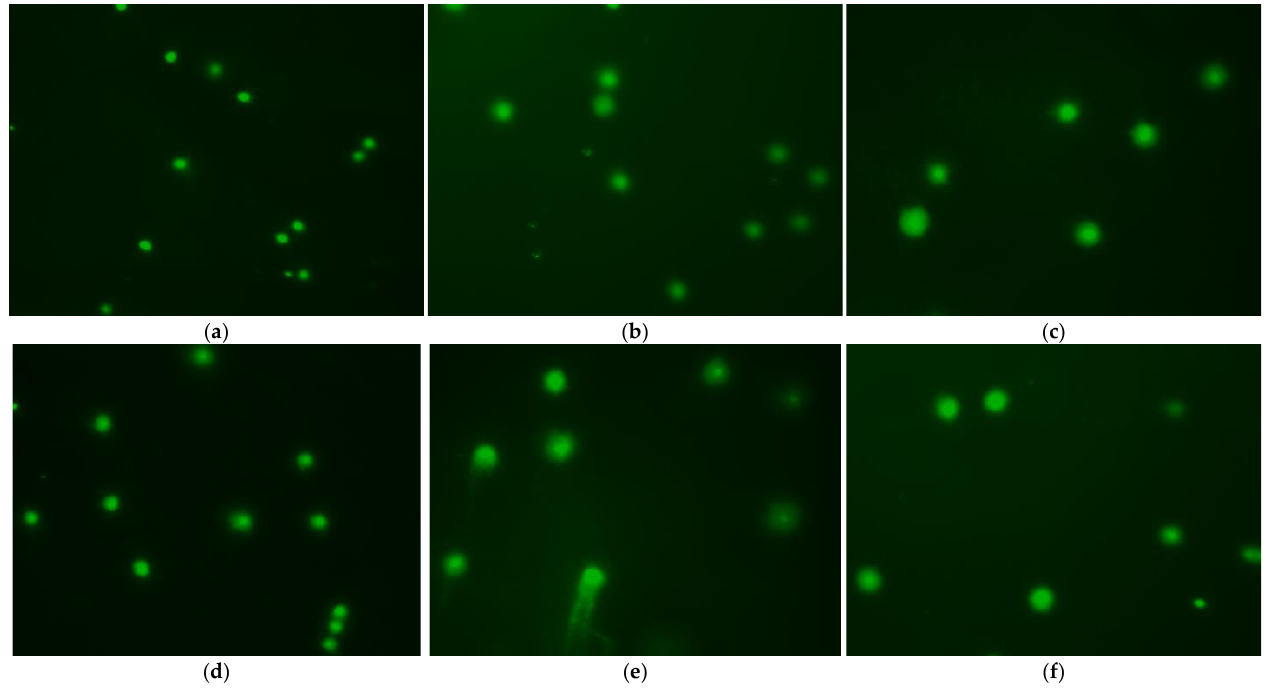
Figure 7. Fluorescent images of frozen and fresh sperm from roughscale sole, Clidoderma asperrimum , using various diluents with 10% DMSO as the cryoprotectant after comet assay. Each comet represents the damage level of DNA in sperm. ( a ) Fresh sperm, ( b ) Cryopreserved sperm using 300 mM Sucrose, ( c ) Cryopreserved sperm using 300 mM Glucose, ( d ) Cryopreserved sperm using Stain’s Solution, ( e ) Cryopreserved sperm using Ringer’s solution, ( f ) Cryopreserved sperm using Ringer’s